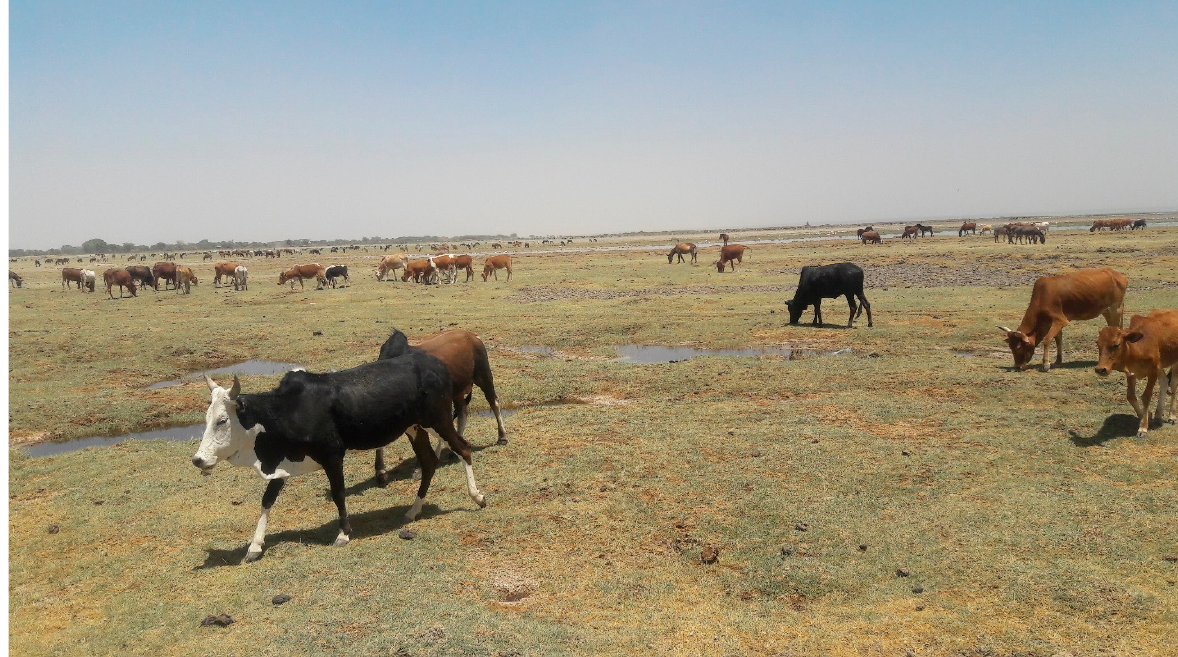
Figure 5. A herd of livestock grazing on an exposed part of the bed of Lake Abijata (note that the lake is saline) (Photo: Amare, 2020). lake is saline) (Photo: Amare,